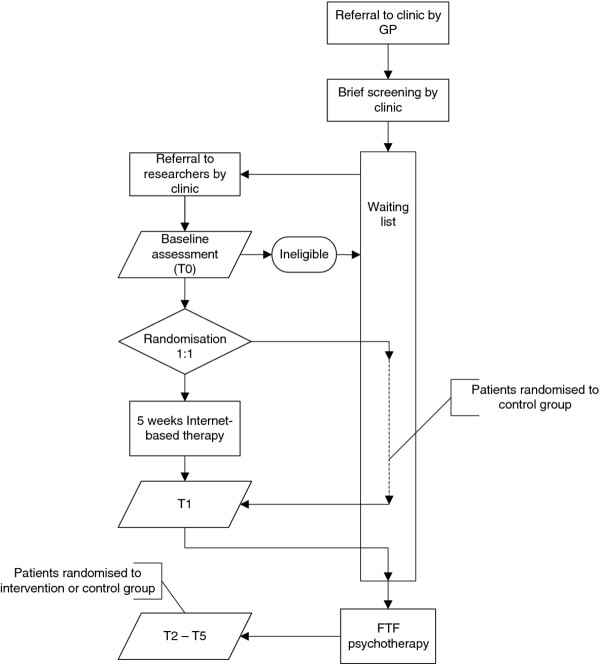
Trial flowchart.